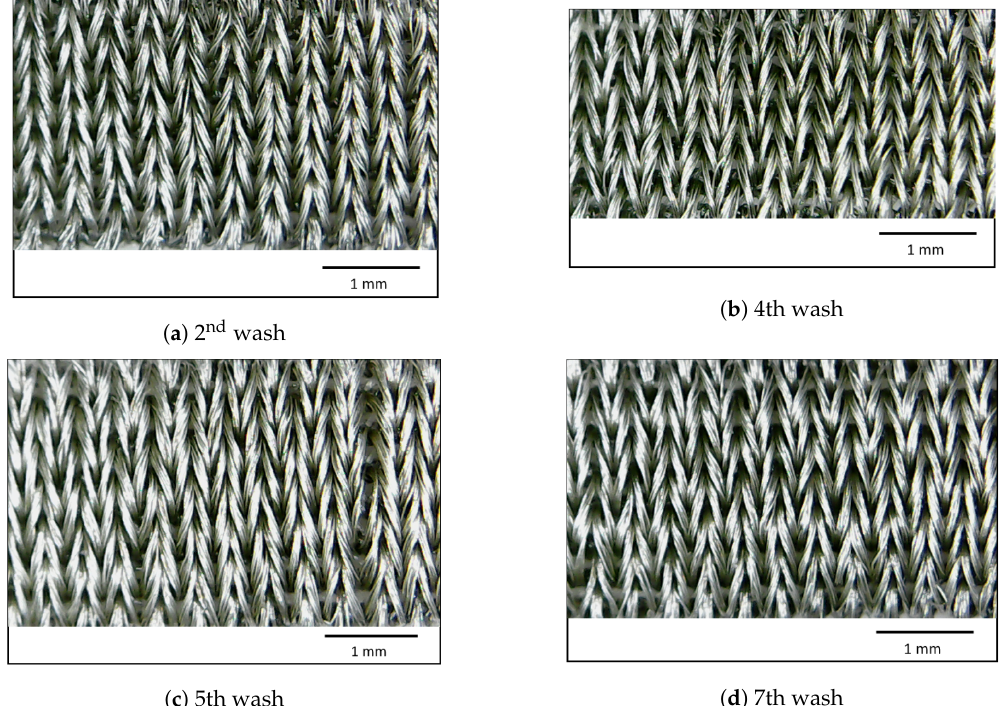
Figure A2. Back side microscopic figures after 2nd, 4th, 5th and 7th wash cycles.